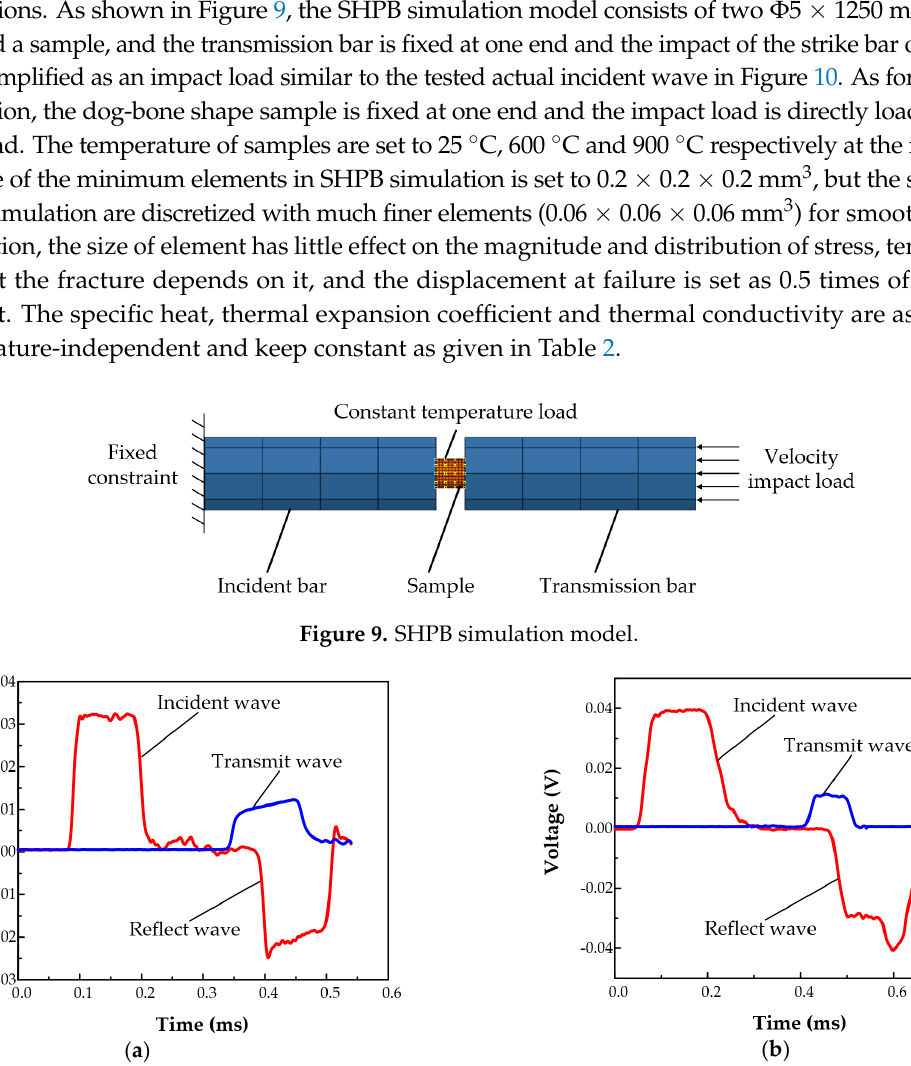
Figure 10. ( a ) Original wave signals in SHPB test; ( b ) original wave signals in SHTB test.